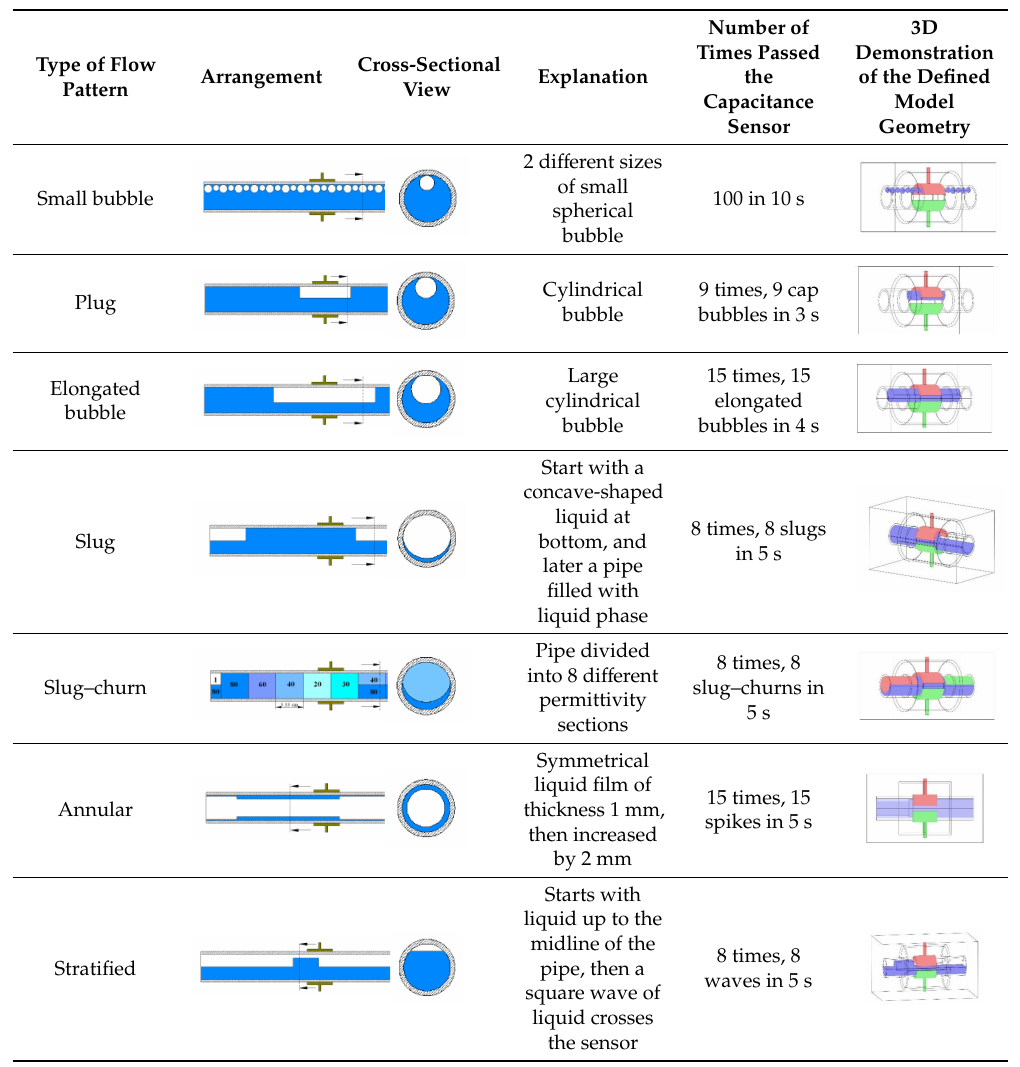
Table 4. Schematic arrangement and explanation of the simulated flow